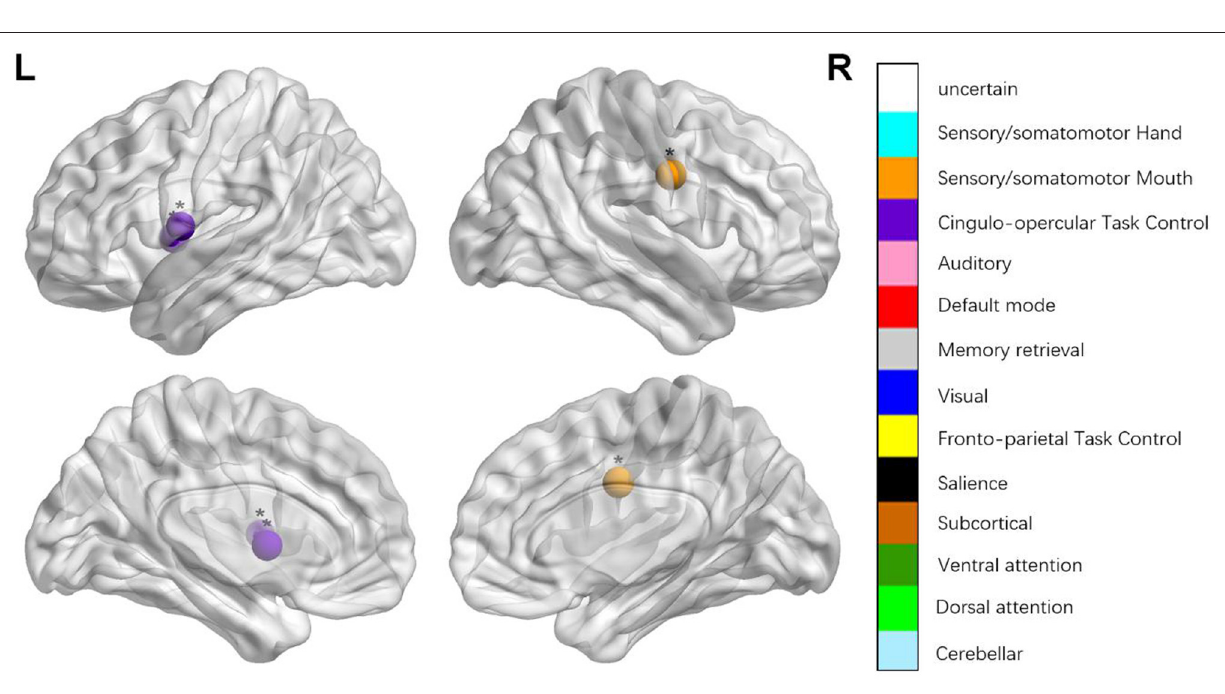
FIGURE 4 | Regions were considered abnormal nodal local efficiency in patients with aphasia if they exhibited significant between-group differences. * p < 0.003787, Bonferroni correction (i.e., 1/264). ** p < 0.000189, Bonferroni correction (i.e., 0.05/264). each threshold point) were used for statistical analyses, data (i.e., the ABC, MMSE, and MoCA scores) in the the potential risk of false-positive rates yielded by multiple aphasic group by using Pearson correlations. Note that as comparisons was alleviated. Therefore, the significance the AUC values (instead of the topological value under